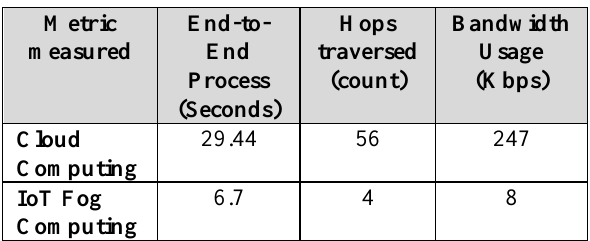
Table 2. Comparing Fog and Cloud Computing